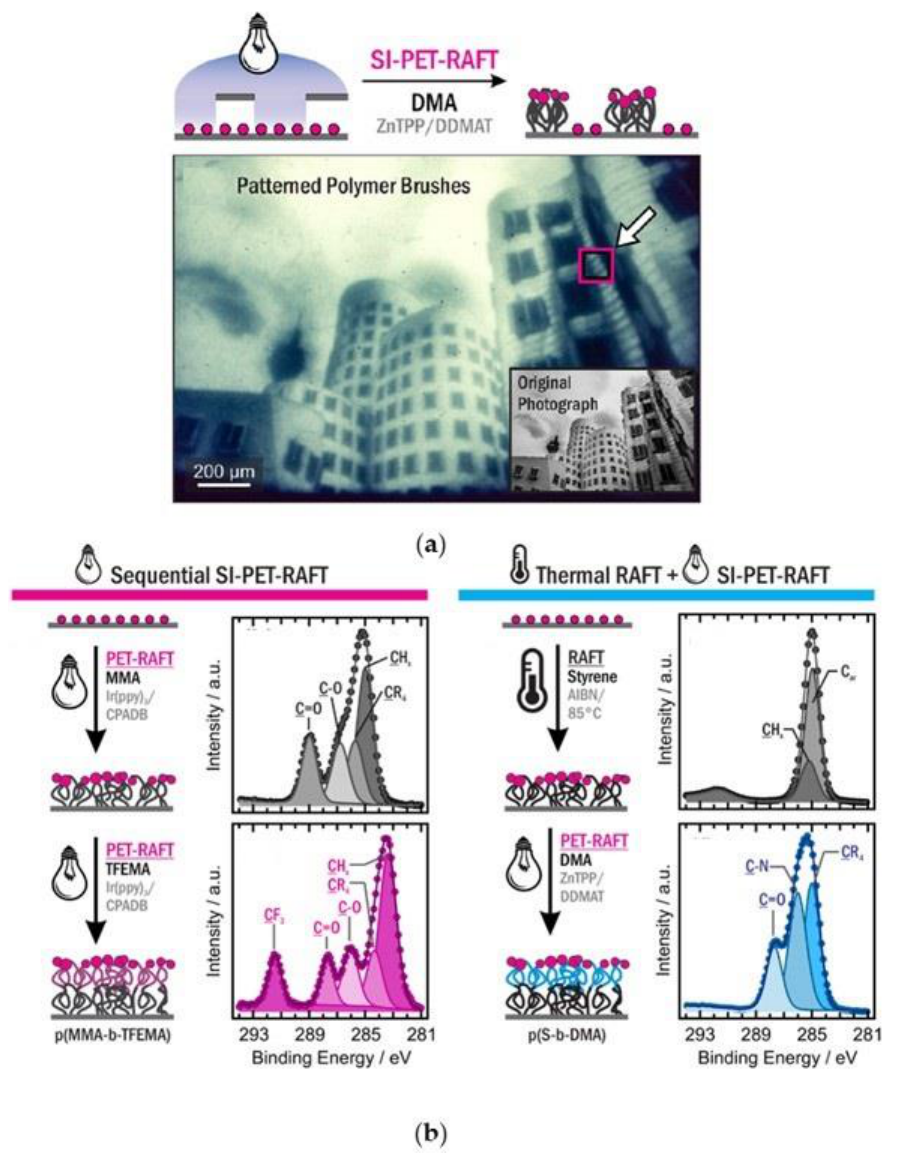
Figure 12. On the top ( a ): SI-PET-RAFT polymerization via localized irradiation of a CTA-functionalized substrate. Spatial control was achieved using a photomask on the SiO 2 substrate via reduction photolithography process. On the bottom ( b ): a combination of thermal initiated and photoinitiated RAFT polymerization. Reproduced with permission from ref. [88].